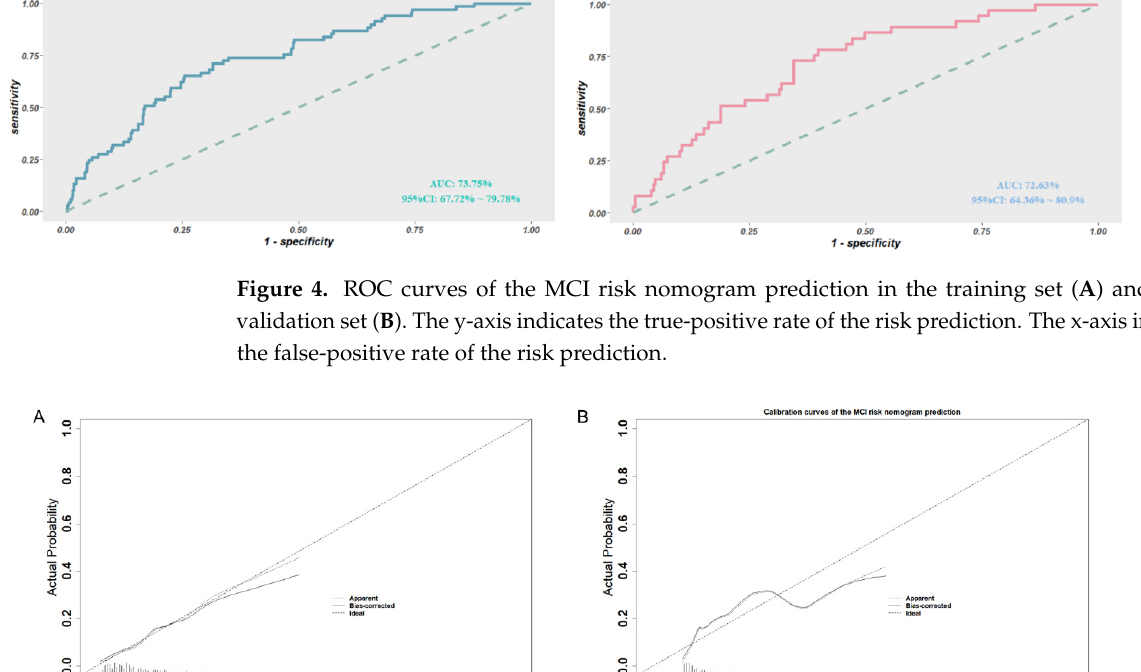
Figure 6. Decision curve analysis for the MCI risk nomogram in the training set ( A ) and in the vali ‐ dation set ( B ). The y − axis measures the net benefit. The thick solid line represents the assumption that no patients have MCI. The thin solid line represents the assumption that all patients have MCI. The dotted line represents the risk nomogram. 4. Discussion MCI is an important period for dementia prevention and treatment [26]; improving its diagnosis rate can help delay the development of dementia and reduce the impact of dementia on people’s quality of life, along with its economic burden. However, there is no consensus on guidelines for routine screening for MCI, resulting in a large number of MCI patients in the community going undiagnosed. Therefore, it is significant to develop a convenient, efficient, and stable screening tool for MCI. In this study, we recruited 886 subjects from 60 communities in western China; their cognitive function was assessed via the MMSE scale, and gastrointestinal myoelectrical activity was measured via EGEG. Fur ‐ thermore, a statistical model for MCI risk prediction was established based on gastroin ‐ testinal electrical parameters, and we found that the model had a good and stable predic ‐ tive effect on MCI. In a recent epidemiological survey [27], MCI was diagnosed using the expanded Mayo Clinic criteria; the results showed that the mean prevalence of MCI was approxi ‐ mately 18.9% among different countries, with the lowest rate in Italy (7.7%) [28] and the highest rate in France (42.0%) [29]. Of the 886 participants from western China included in this study, 106 were found to have MCI, with an incidence of 12%, which is consistent with the previous findings. We assessed MCI using the MMSE scale, which is one of the most common cognitive screening tools used by general practitioners and specialists in Western countries. The scale can simply assess multiple cognitive domains with a